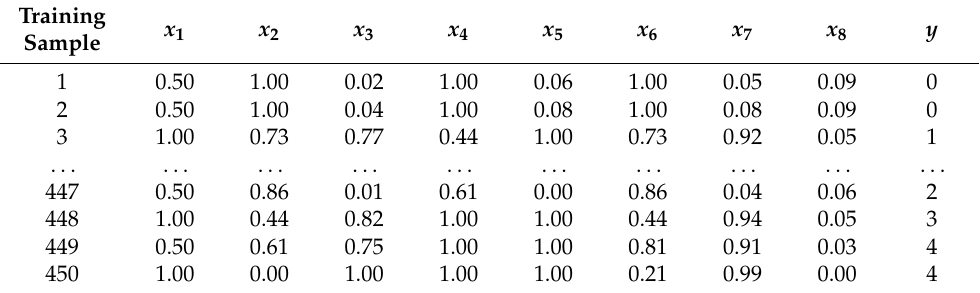
Table 4. The training sample.